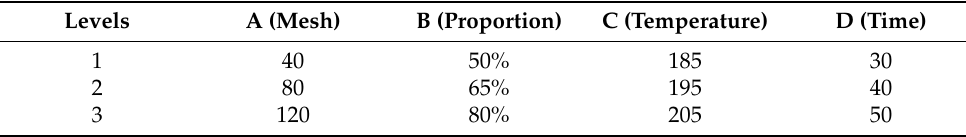
Table 2. The parameters and levels for processing.